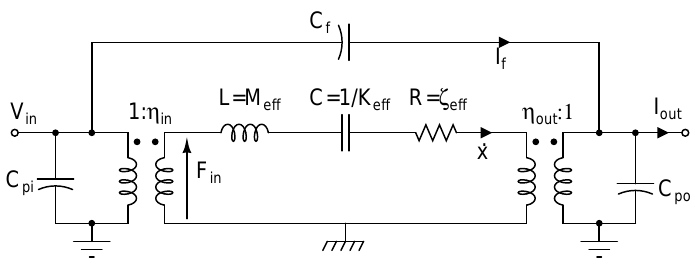
Figure 3. Equivalent electrical representation of an electrostatic resonator including the feedthrough capacitor C f and parasitic capacitors C pi and C po Modelling of Nonlinearities